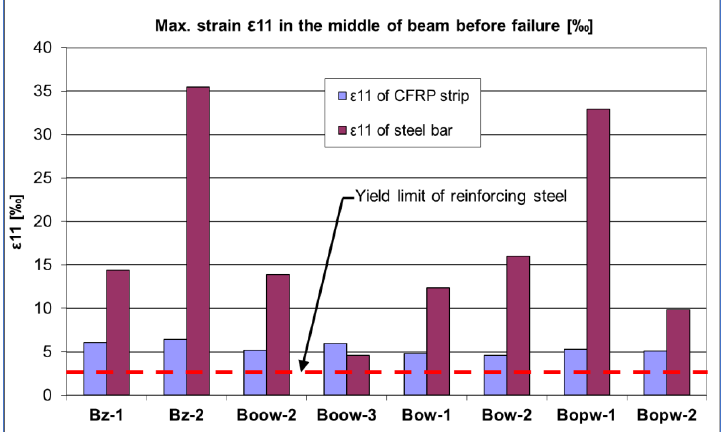
Figure 7. Steel strains of middle bar and CFRP strip in the middle of beam span before failure. The high utilization of the composite strip at the level of 5.98% was obtained for the beam completely relieved before strengthening. On the other hand, the results of the analysis of CFRP strip strains of beams that were strengthened at the load corresponding